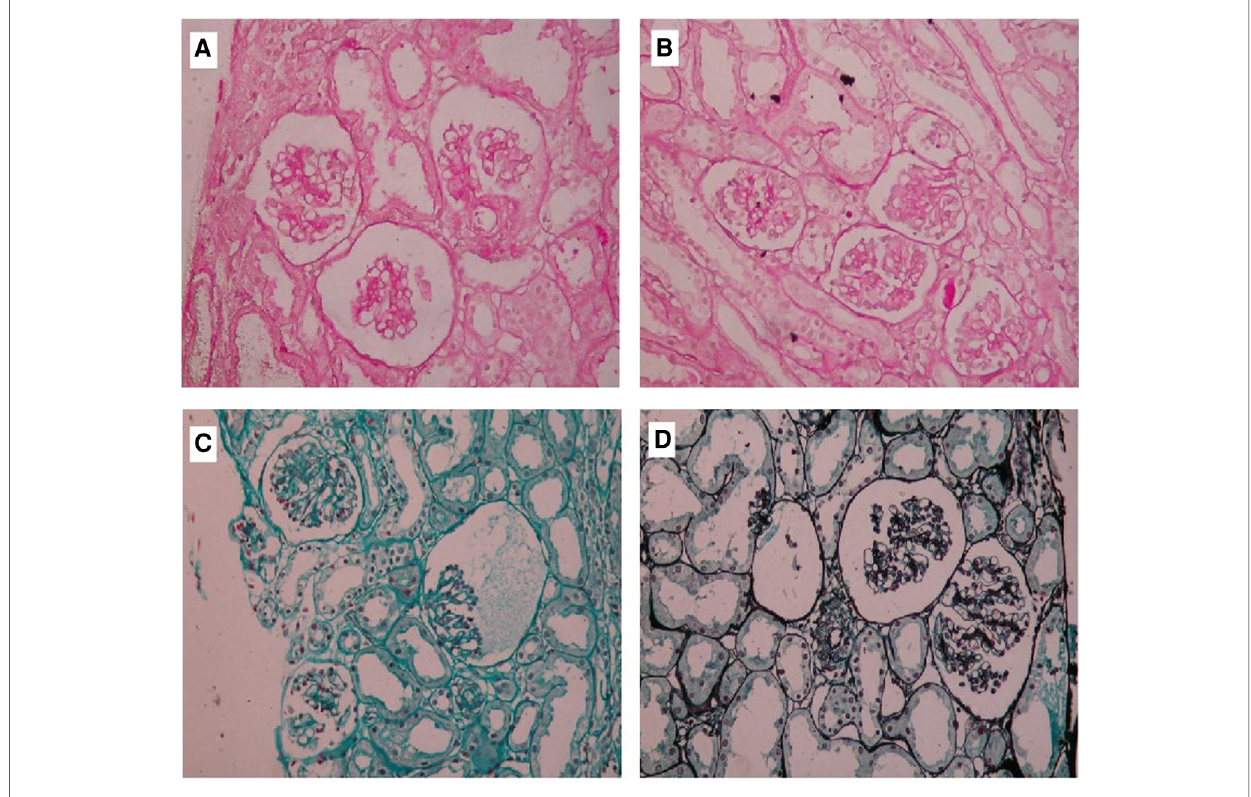
FIGURE 2 Renal biopsy in a patient with this boy. Photomicrograph of renal biopsy specimen with HE, PAS ( A,B ) stain showed the glomeruli are small and underdeveloped and one juxtaglomerular complex was enlarged and MASSON, PASM ( C,D ) stain showed glomerular basement membrane.